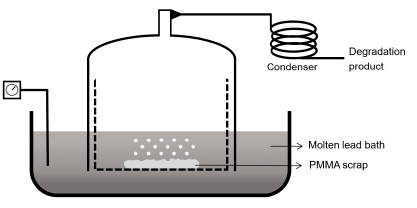
Figure 18. Molten-lead bath technology patented by Segui et al. [126].